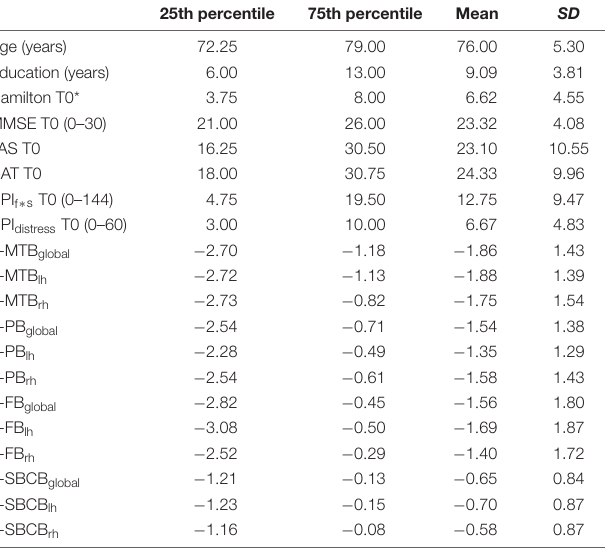
TABLE 1 | Neuropsychological assessment and morphometrical z-scores of the sample.